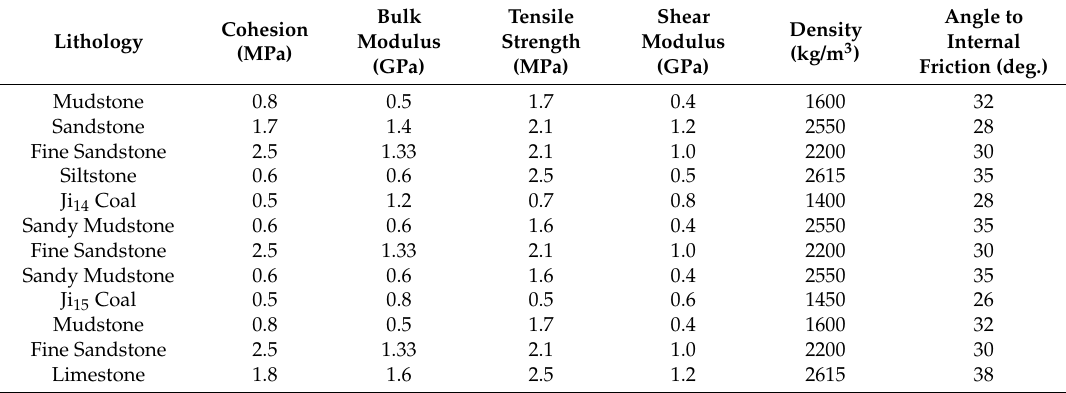
Figure 8. Establishment of numerical models. ( a ) FLAC 3D model and ( b ) cross section and measurement station of backfilling and caving mixed mining (BCMM) coalface. Table 4. Mechanical parameters of the coal-rock mass.